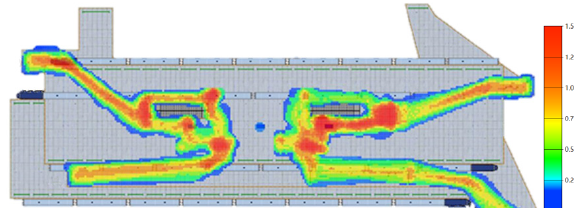
Figure 12. Pedestrian distribution density at 240 s.